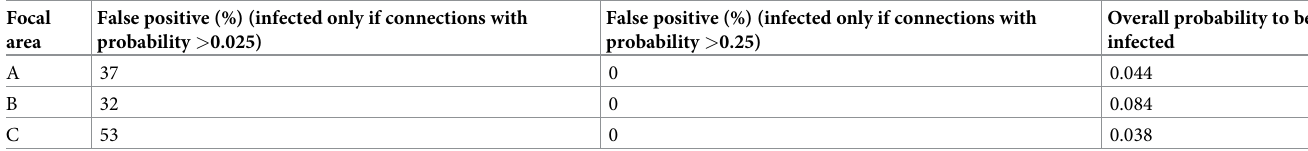
Table 5. Cross validation results for uninfected houses. Focal